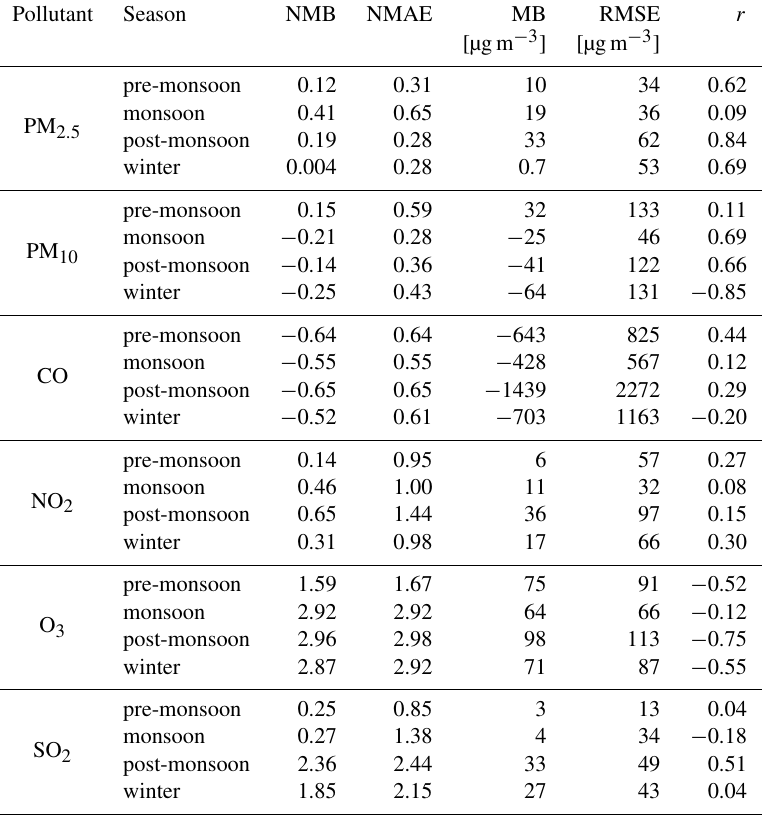
Table B3. Statistical evaluation of model performance with ground-based measurements for main PM and main gas